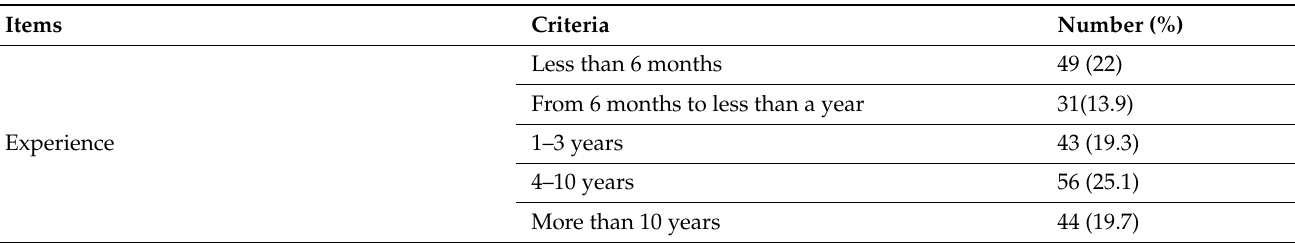
Table 1. Participants’ demographic